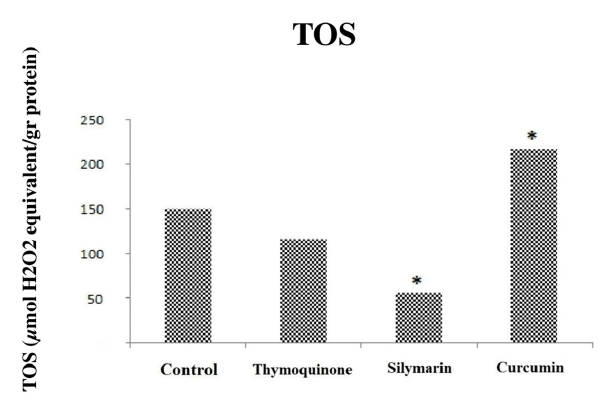
Fig. 2 - Comparison of total oxidant status (TOS) values between groups. Control = ischemia-reperfusion (I-R) group; Thymoquinone = thymoquinone + I-R group; Silymarin = silymarin + I-R group; Curcumin = curcumin + I-R group. *=statistically significant